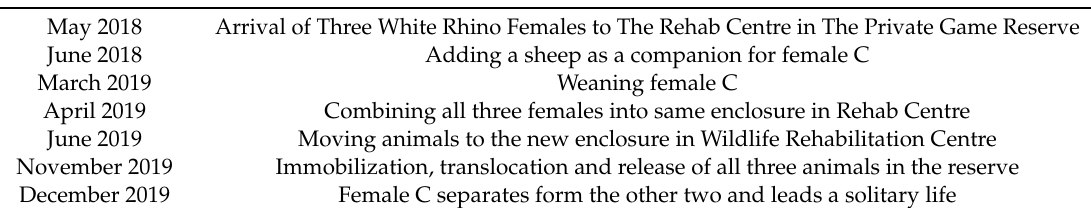
Table 2. Timeline of key points in the rehabilitation process and